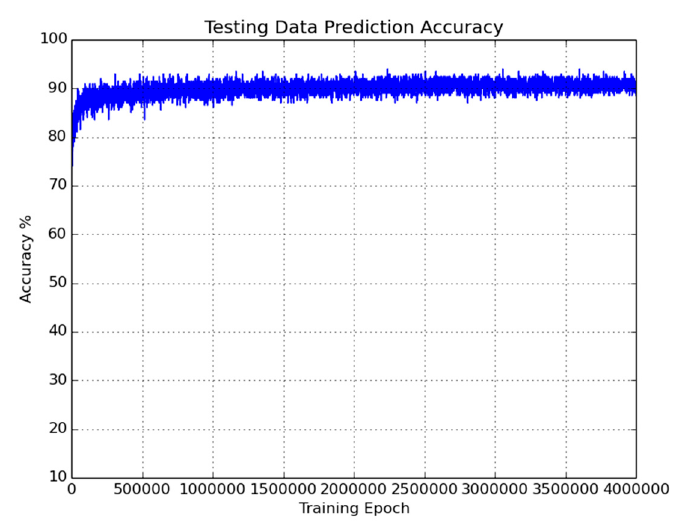
Figure A3. Testing accuracy curve.